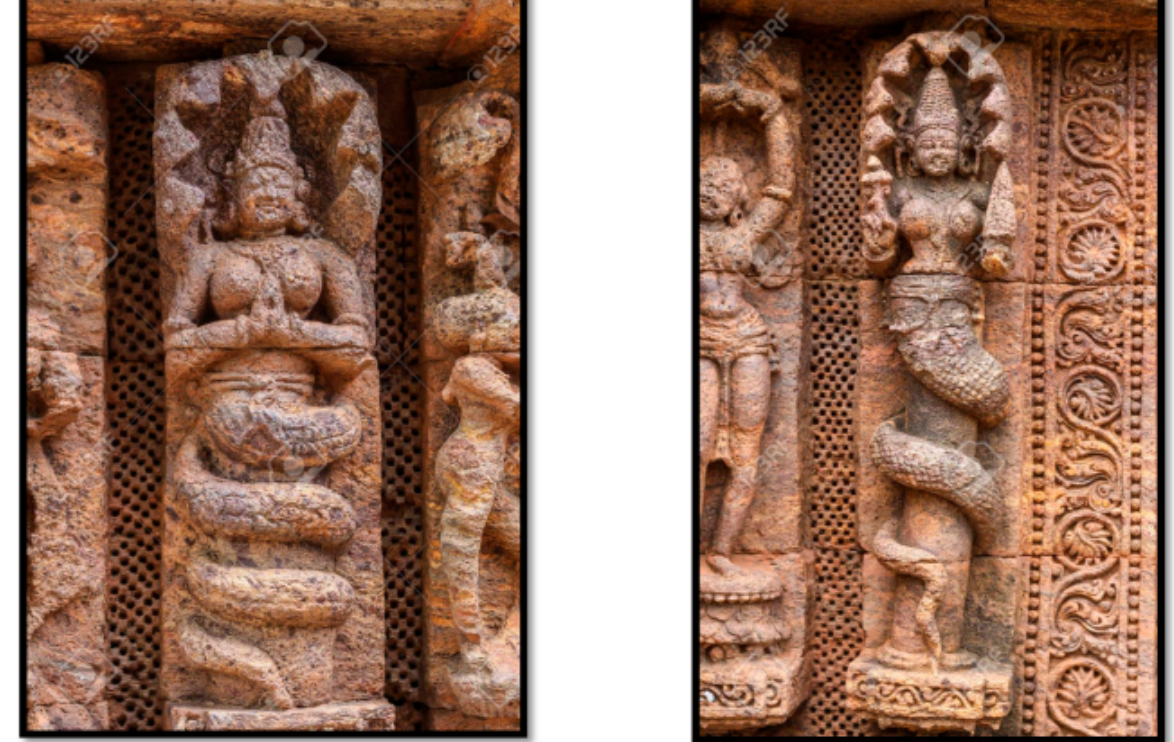
Figure 16. Nagini on the Sun-Temple, chlorite stone, Konark, Odisha, ca.1250 CE, Eastern Ganga